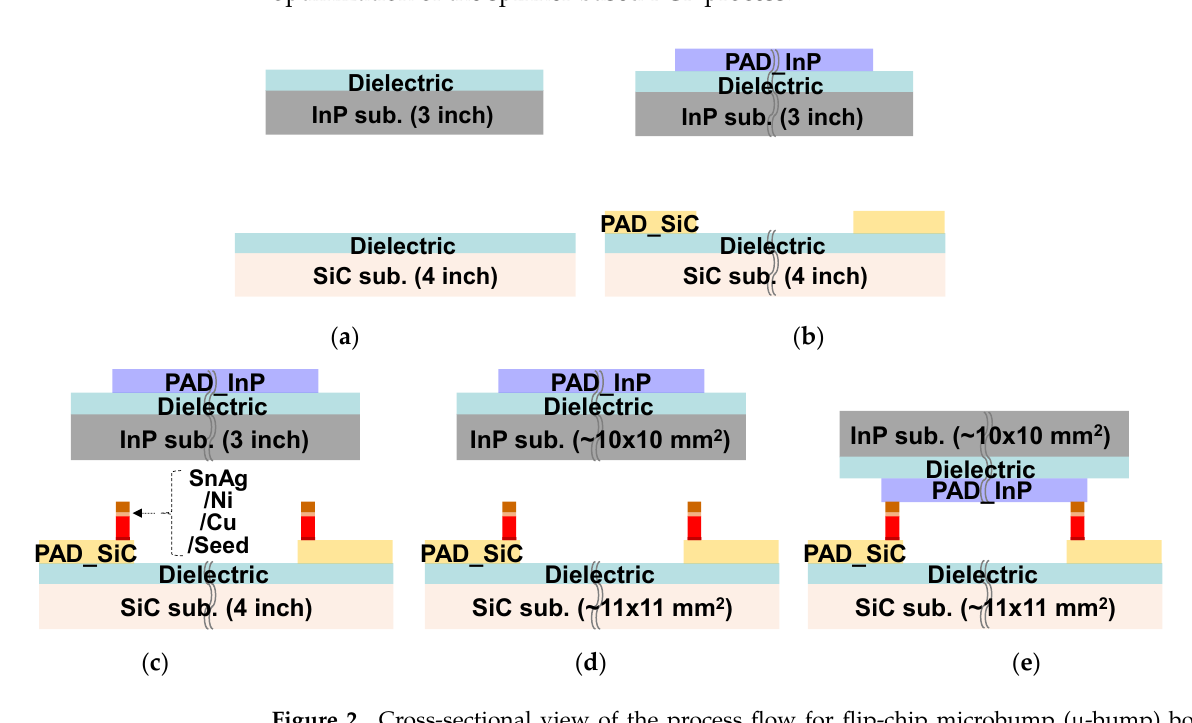
Figure 2. Cross-sectional view of the process flow for flip-chip microbump ( µ -bump) bonding technology between InP and SiC substrates: ( a ) dielectric layer deposition; ( b ) formation of PAD metal; ( c ) formation of microbump metal; ( d ) dicing; ( e ) flip-chip SnAg-to-Au solder bonding.